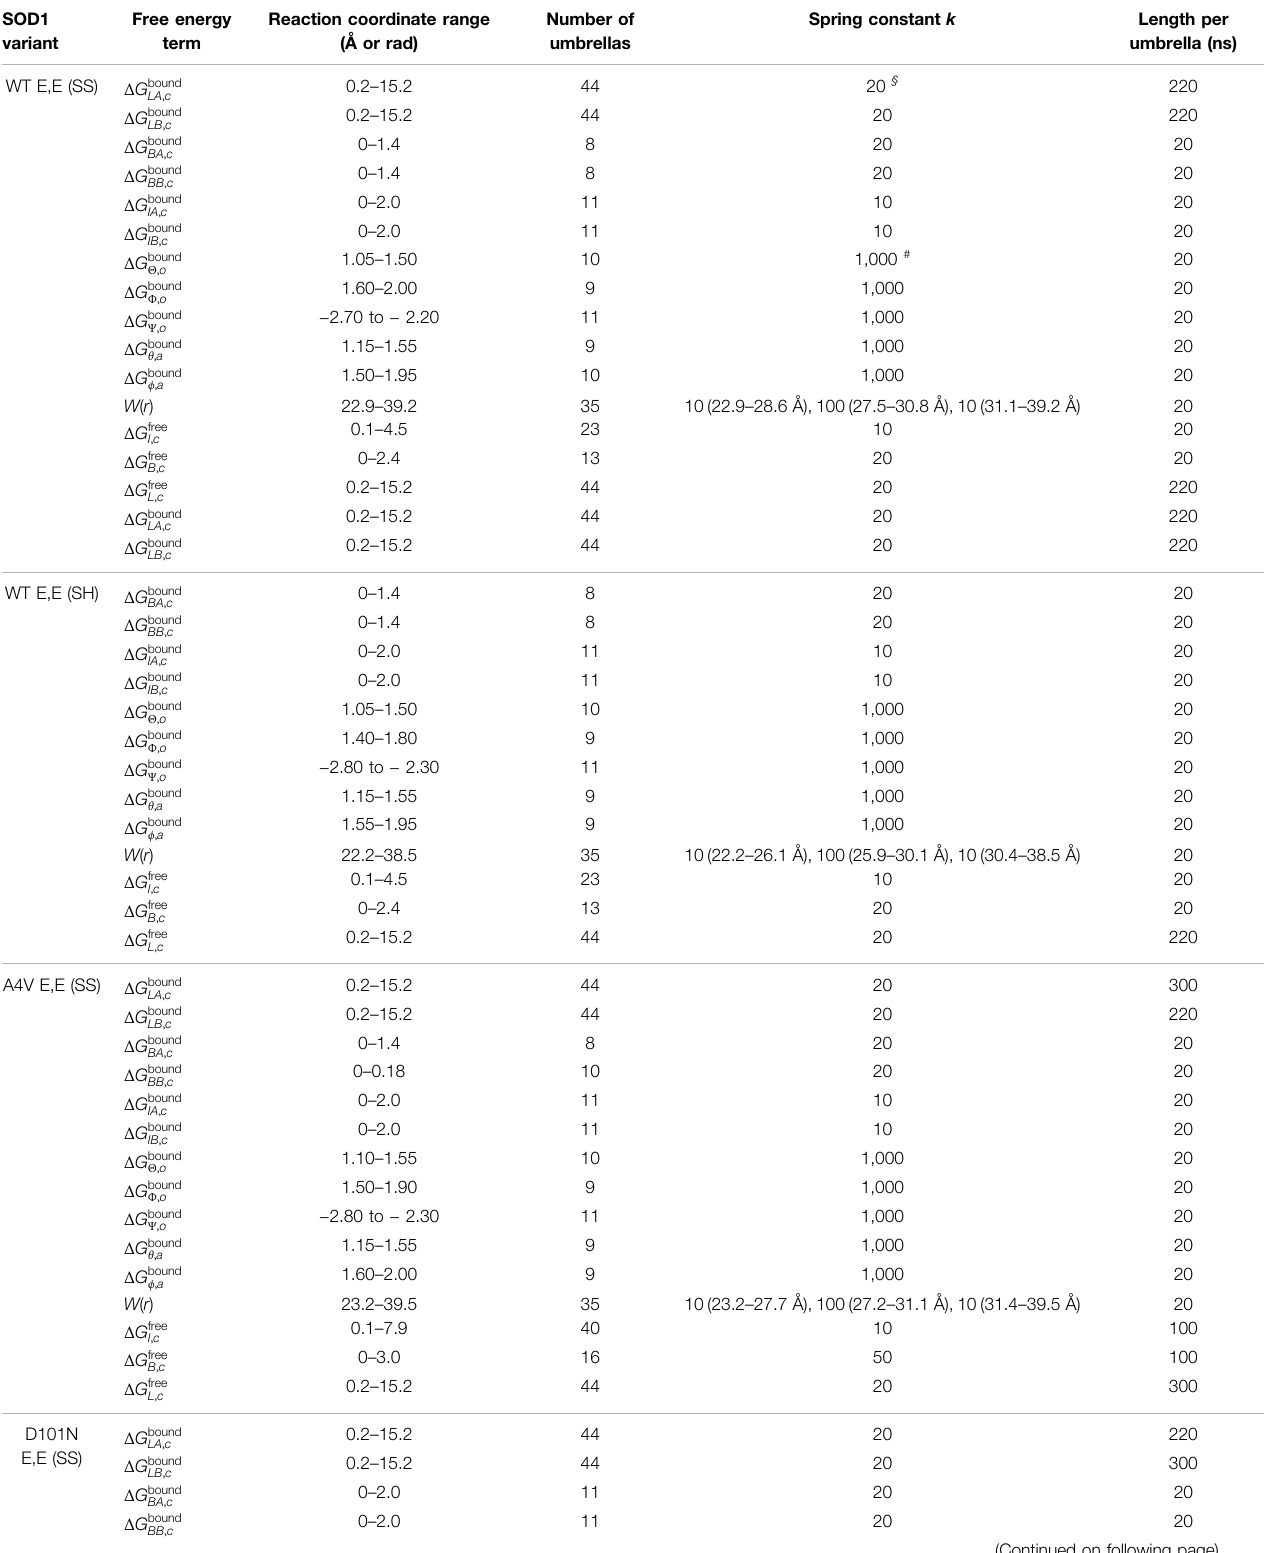
TABLE3| TheparametersofREMD-USforcalculatingeachfreeenergyterm.Unitsare § =kcal/mol/Å 2 for Δ G LX , c ( X = A , B boundorfree), Δ G BX , c , Δ G IX , c ,and W ( r ).Unitsare # = kcal/mol/rad 2 for Δ G bound